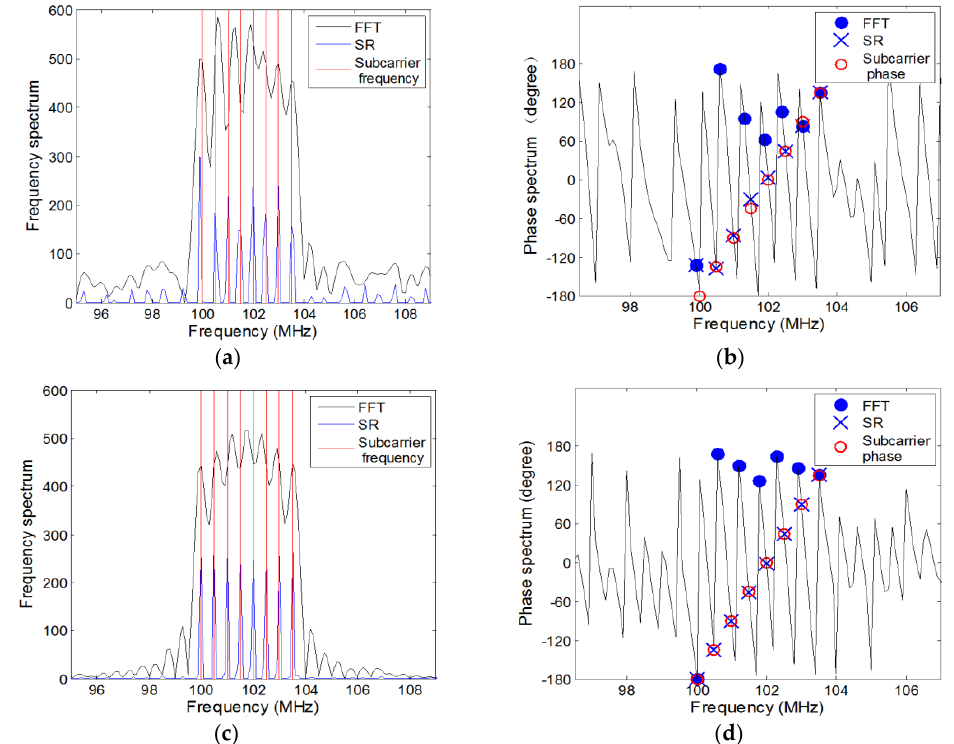
Figure 5. OFDM signal spectrum: ( a ) Frequency spectrum (SNR = 0 dB); ( b ) Phase spectrum (SNR = 0 dB); ( c ) Frequency spectrum (SNR = 20 dB); ( d ) Phase spectrum (SNR = 20 dB).